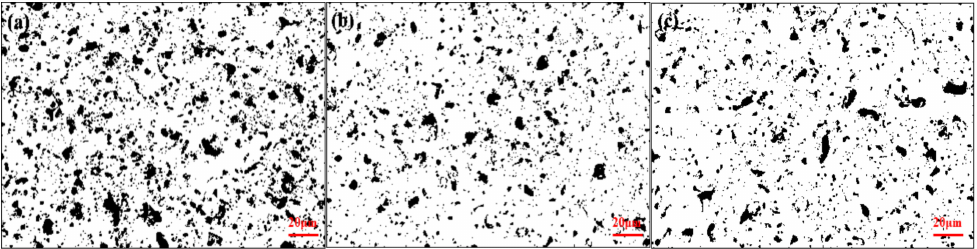
Figure 2. Surface porosity of MAO layers on TC4 alloy with different additives (pores marked in